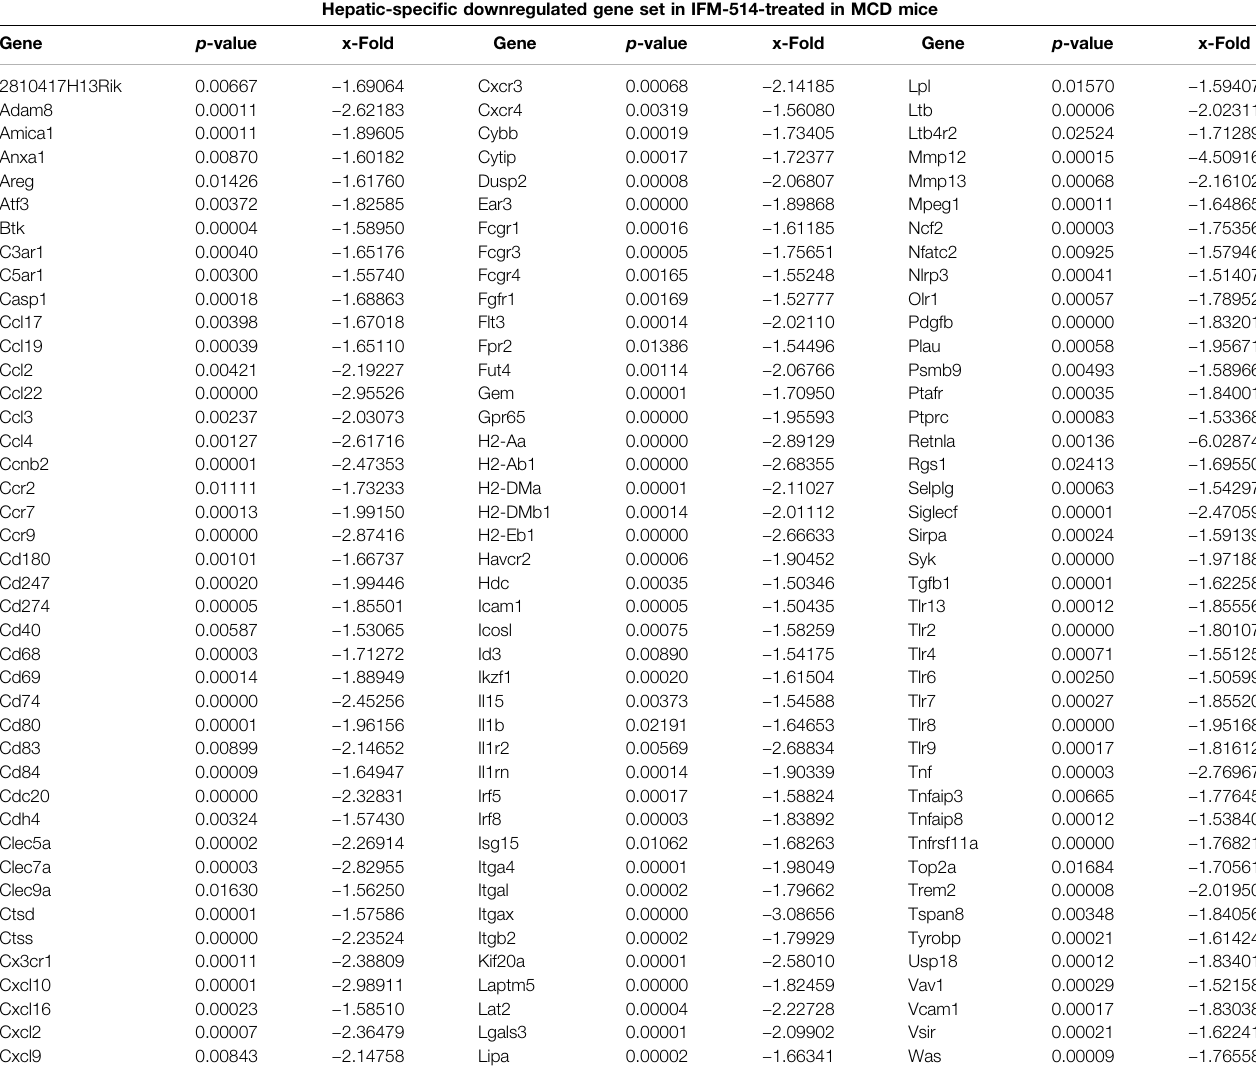
TABLE 2 | IFM-514 changes the hepatic gene expression of in fl ammasome-related and proin fl ammatory cytokines in MCD-fed ApoE -/- mice. Table shows all genes signi fi cantly downregulated in IFM-514-treated MCD-fed mice. Hepatic-speci fi c downregulated gene set in IFM-514-treated in MCD